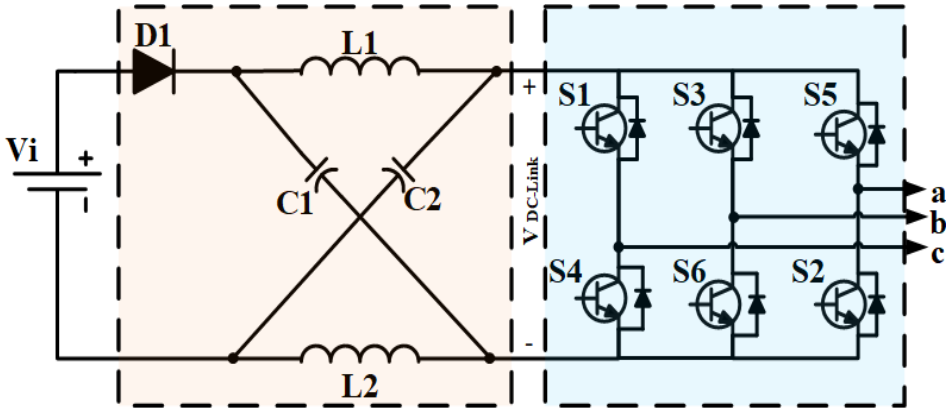
Figure 1. Basic x-shaped topology for ZSI.